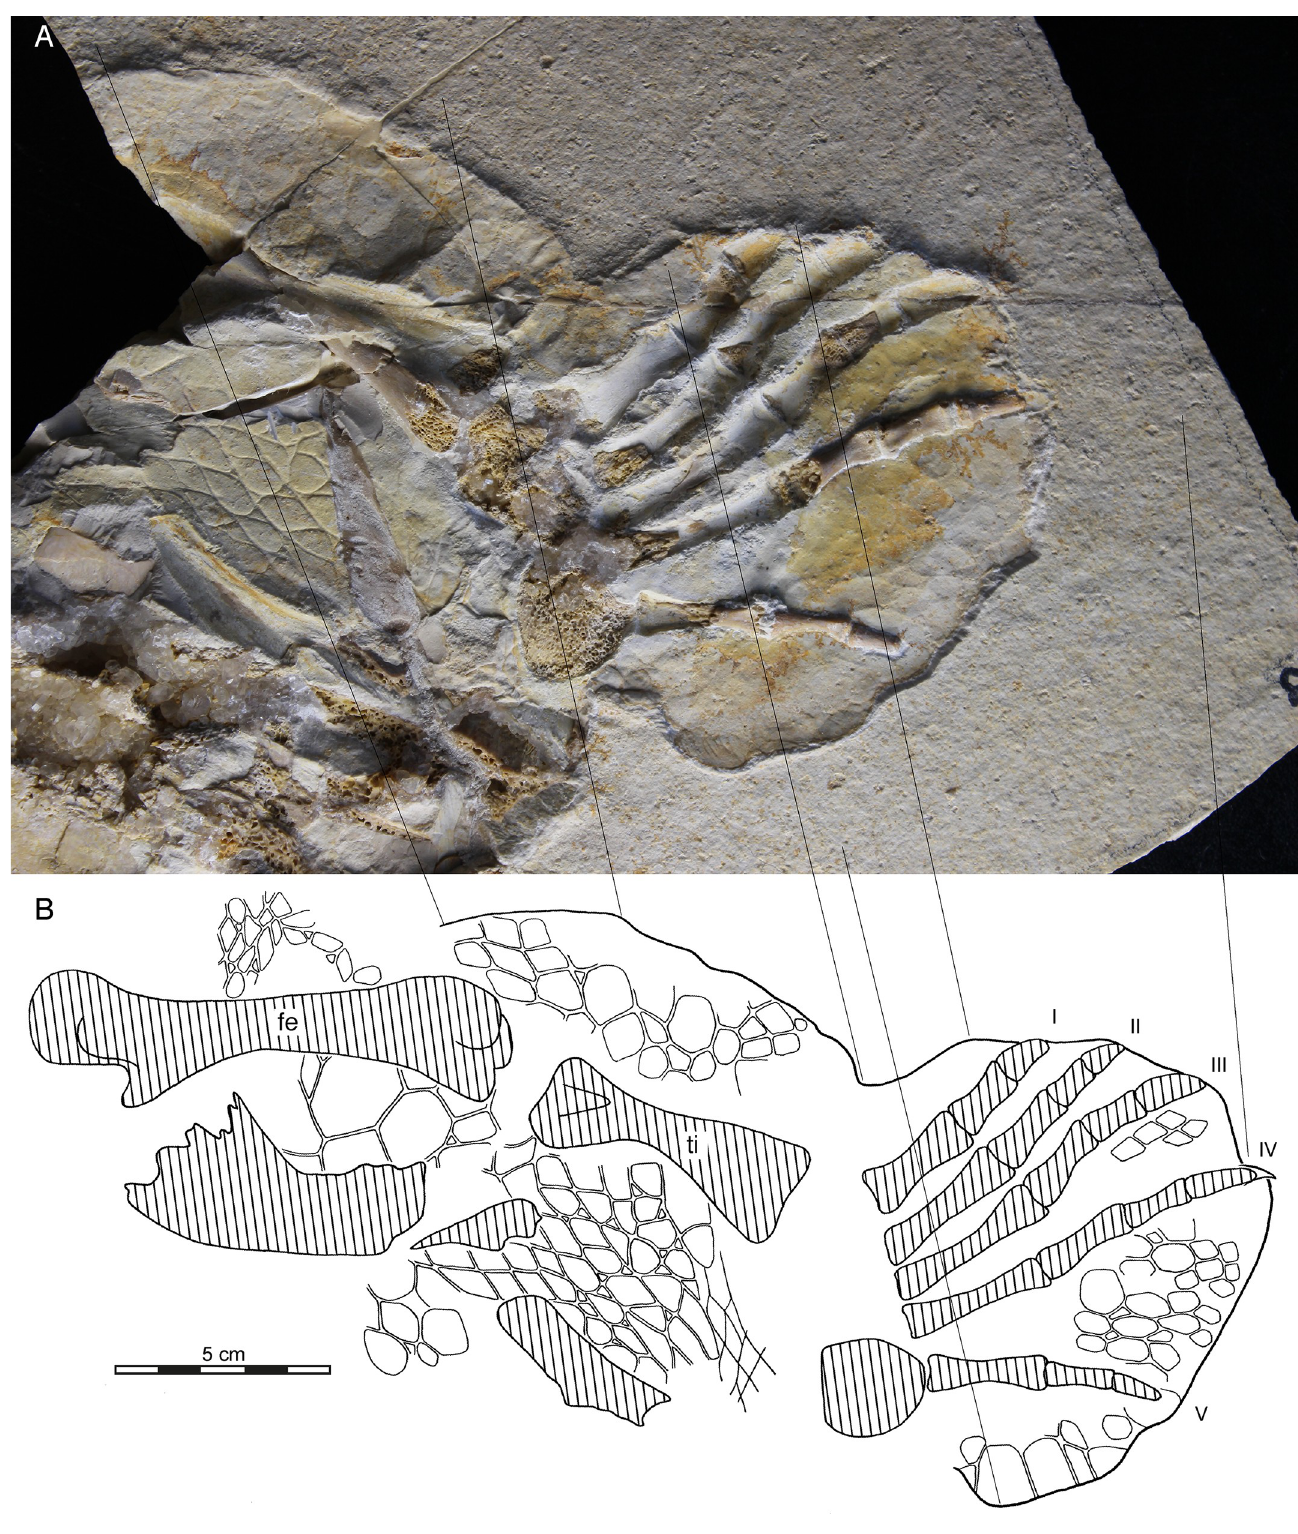
Fig 1. JME 3995, Thalassochelydia indet., Late Jurassic (early Tithonian) of Birkhof, Bavaria, Germany. Photograph (top) and interpretive line drawing (bottom) in ventral view. Hatched areas denote bones. Roman numerals denote digit identity. Note large patches of scaly skin preserved across the specimen. For additional images, please see S1 Appendix. Abbreviations: fe, femur; ti,